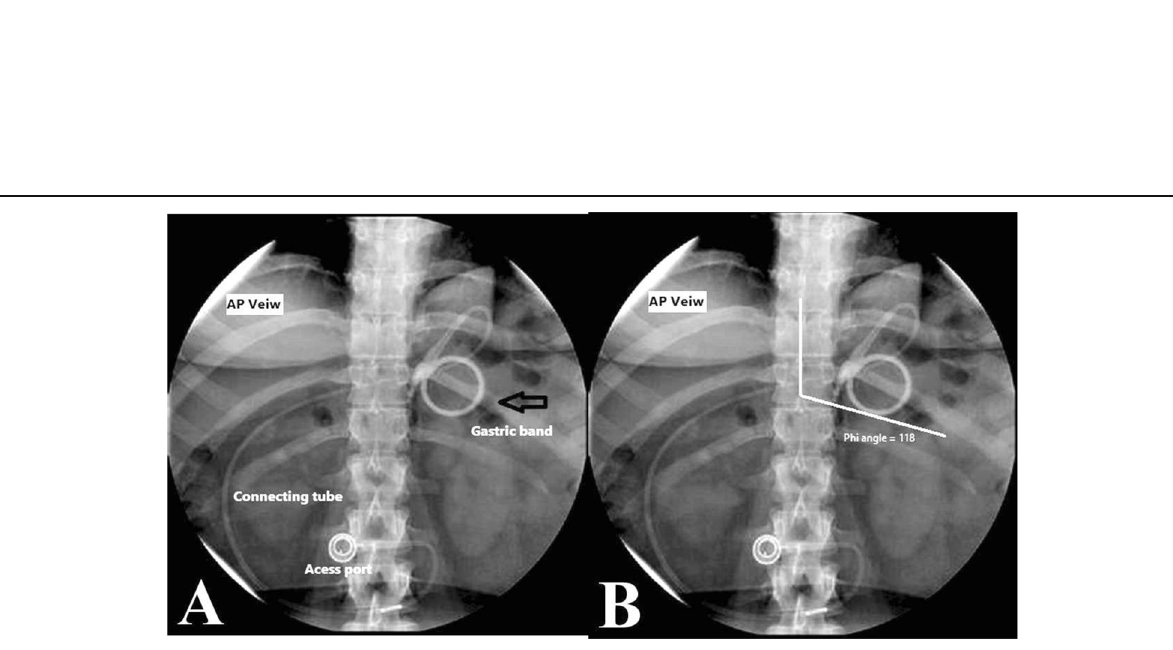
Fig. 2 A 22-year-old female patient presented with persistent vomiting 2 weeks post-gastric band. Plain X-ray abdomen erect: A-P view ( a , b ), gastric band positioned enface (vertical) giving O sign appearance characteristic for band slippage (black arrow) and widening phi angle = 118°. Diagnosis: band slippage